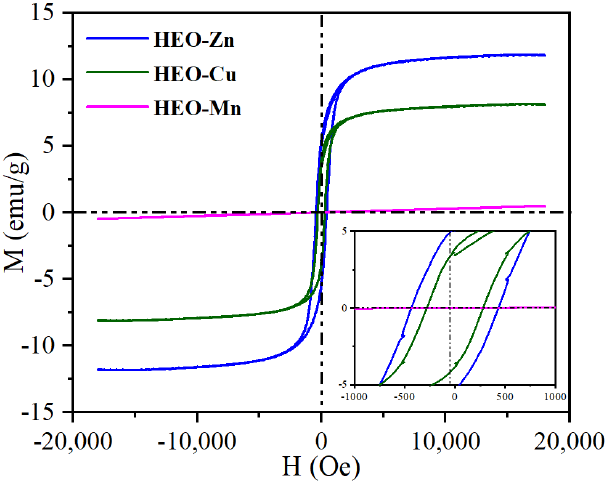
Figure 4. ( a – c ) TEM and ( d – f ) high-resolution TEM images of HEO − Zn, HEO − Cu, and HEO − Mn samples, respectively. Insets of ( d – f ) are magnified images of the relevant areas marked in ( d – f ).